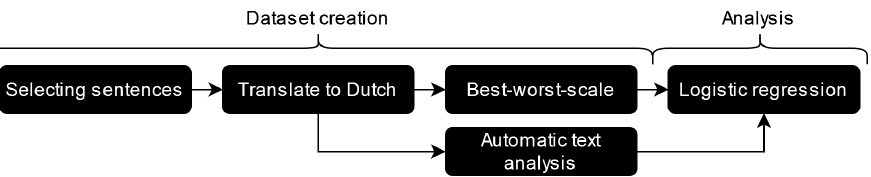
Figure 1. Global research design. The first part is dataset creation, and the second part is